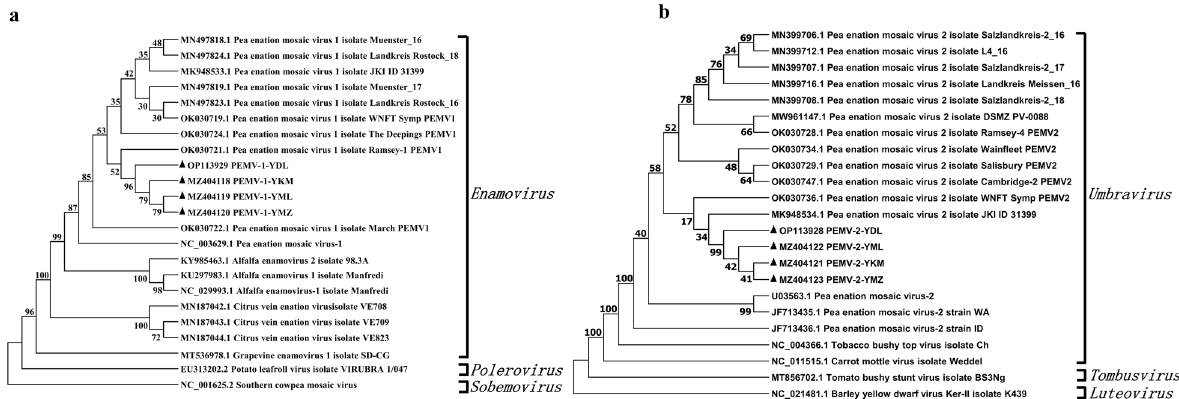
Fig. 3 Construction of the Neighbor-joining phylogenetic tree using the complete genome sequences of PEMV-1, PEMV-2, and other related viruses. The statistical significance of the branches was calculated by bootstrap with 1000 replicates. a Phylogenetic tree was constructed using the nucleotide sequences of PEMV-1 and other viruses in the 3 genera Enamovirus , Polerovirus , and Sobemovirus . b Phylogenetic tree was constructed using the nucleotide sequences of PEMV-2 and other viruses in the genera Umbravirus , Tombusvirus , and Luteovirus